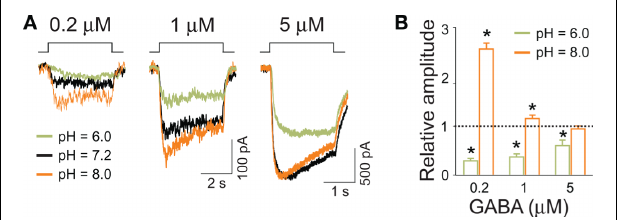
FIGURE 5 |Amplitudes of currents elicited by low GABA concentrations are up regulated by basic and down regulated by acidic pH. (A) Typical current traces elicited by applications of GABA concentrations indicated above current traces at different pH values indicated by colors (green – 6.0, black – 7.2, orange – 8.0). Note that for (GABA) = 1 μ M, alkalinization of extracellular solution enhances the current amplitudes. (B) Statistics for relative changes in current amplitudes (with respect to that measured at pH = 7.2) for pH = 6.0 (green bars) and pH = 8.0 (orange bars). Note that especially at very low (GABA; 0.2 μ M) basic pH strongly enhances the amplitude, the effect that is qualitatively opposite to that observed at saturating (GABA; Figure 4 ). Modified from Mozrzymas et al. (2003b) with